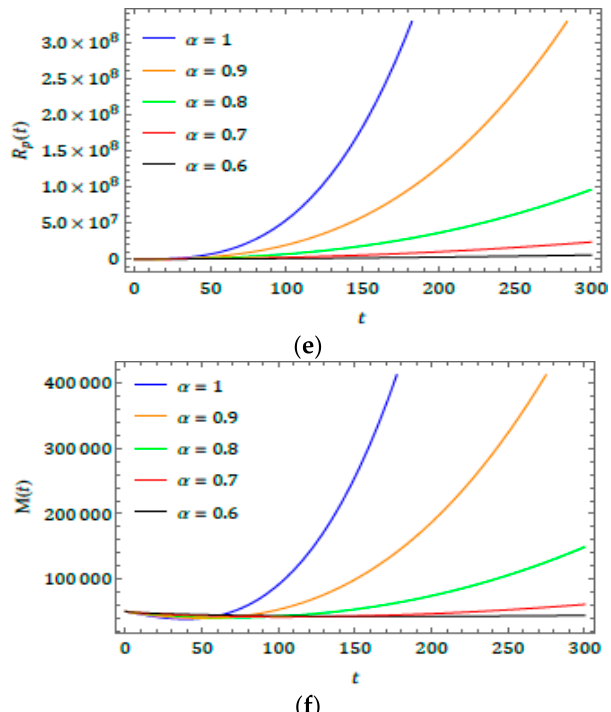
Figure 2. Behavior of results obtained for ( a ) S p ( t ) , ( b ) E p ( t ) , ( c ) I p ( t ) , ( d ) A p ( t ) , ( e ) R p ( t ) , and ( f ) M ( t ) for distinct fractional order ( α )